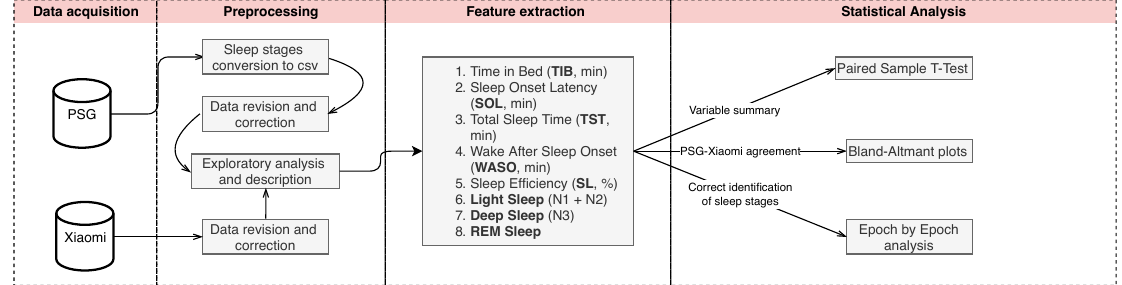
Figure 1. Sleep data validation